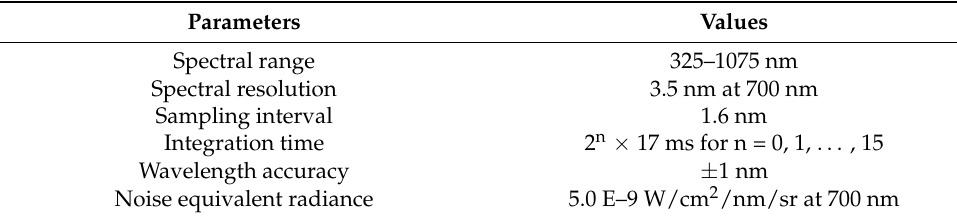
Table 3. The specific parameters of FieldSpec Hand Held.